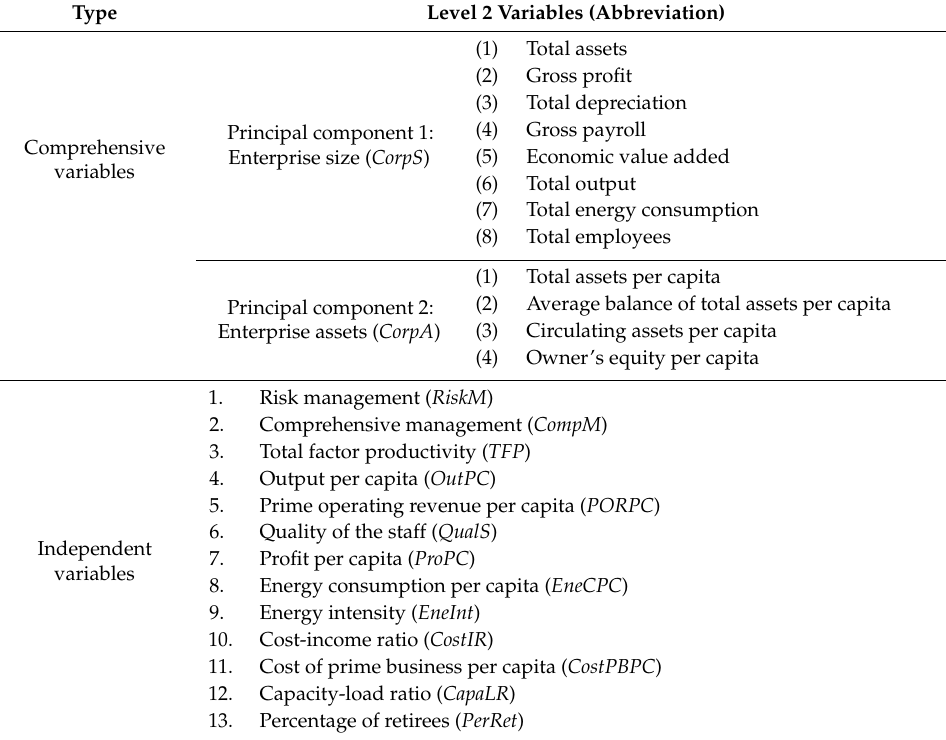
Table 1. Summary of enterprise contextual